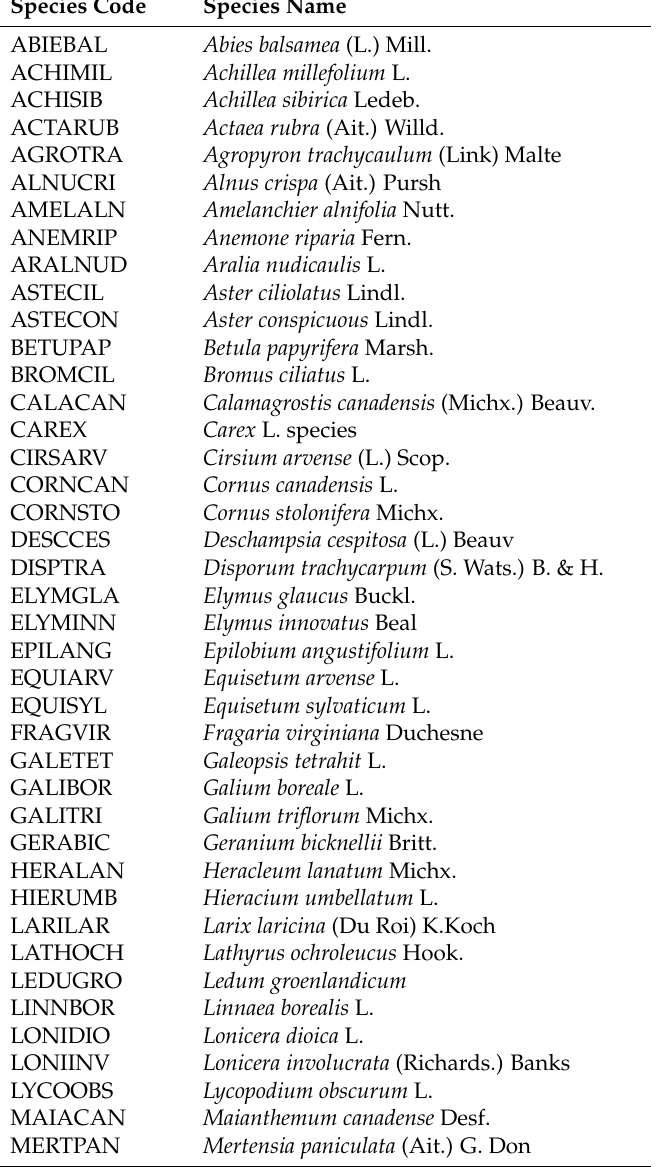
Table A1. Full Species Names for All Species Recorded in 2014 (Nomenclature Follows